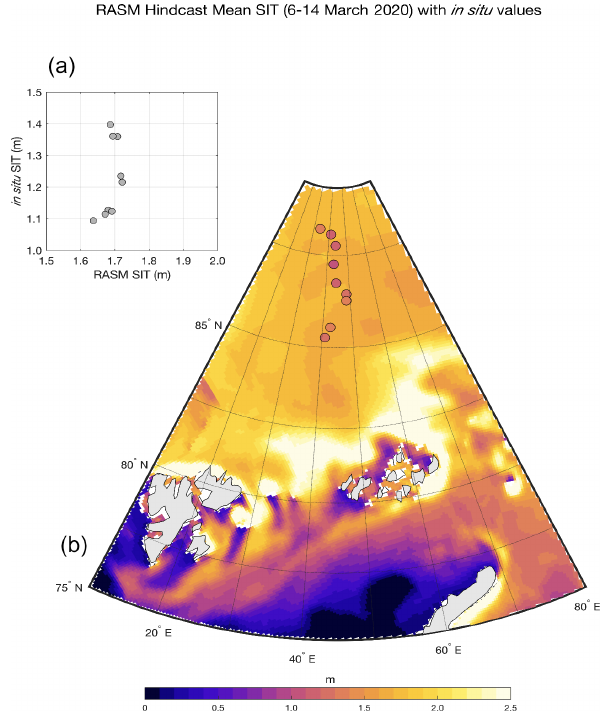
Figure 8. Panel (a) compares the in situ sea ice thickness measure- ments (m) with the corresponding RASM simulations at all points indicated by circles in (b) , which shows the mean sea ice thick- ness (m; shading) from the RASM hindcast simulation during 6– 14 March and daily EM (Electromagnetic induction) ice thickness measurements (m; circles) taken on the RV Kapitan Dranitzyn